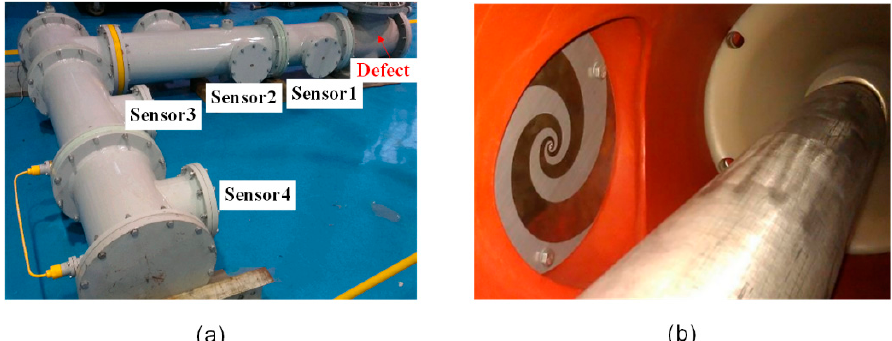
Figure 9. GIS experimental platform: ( a ) GIS tank and the positions of the UHF sensors; ( b ) the installation of the UHF sensors inside the tank.